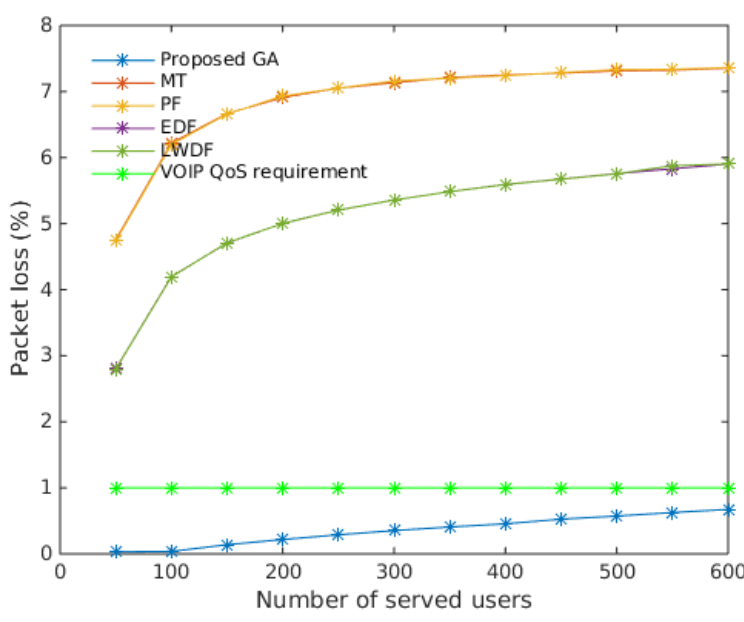
Figure 9. Overall average packet loss with 95% confidence interval. Proposed GA showed better performances.